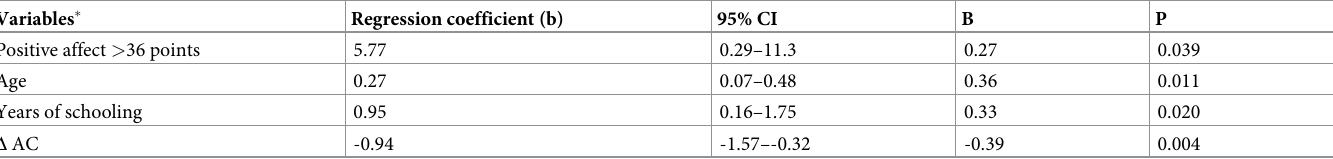
Table 11. Multivariate linear regression analysis by backward criterion to evaluate factors independently associated with BHEI-R variation of patients with meta- bolic syndrome, Porto Alegre, Brazil (n = 63).